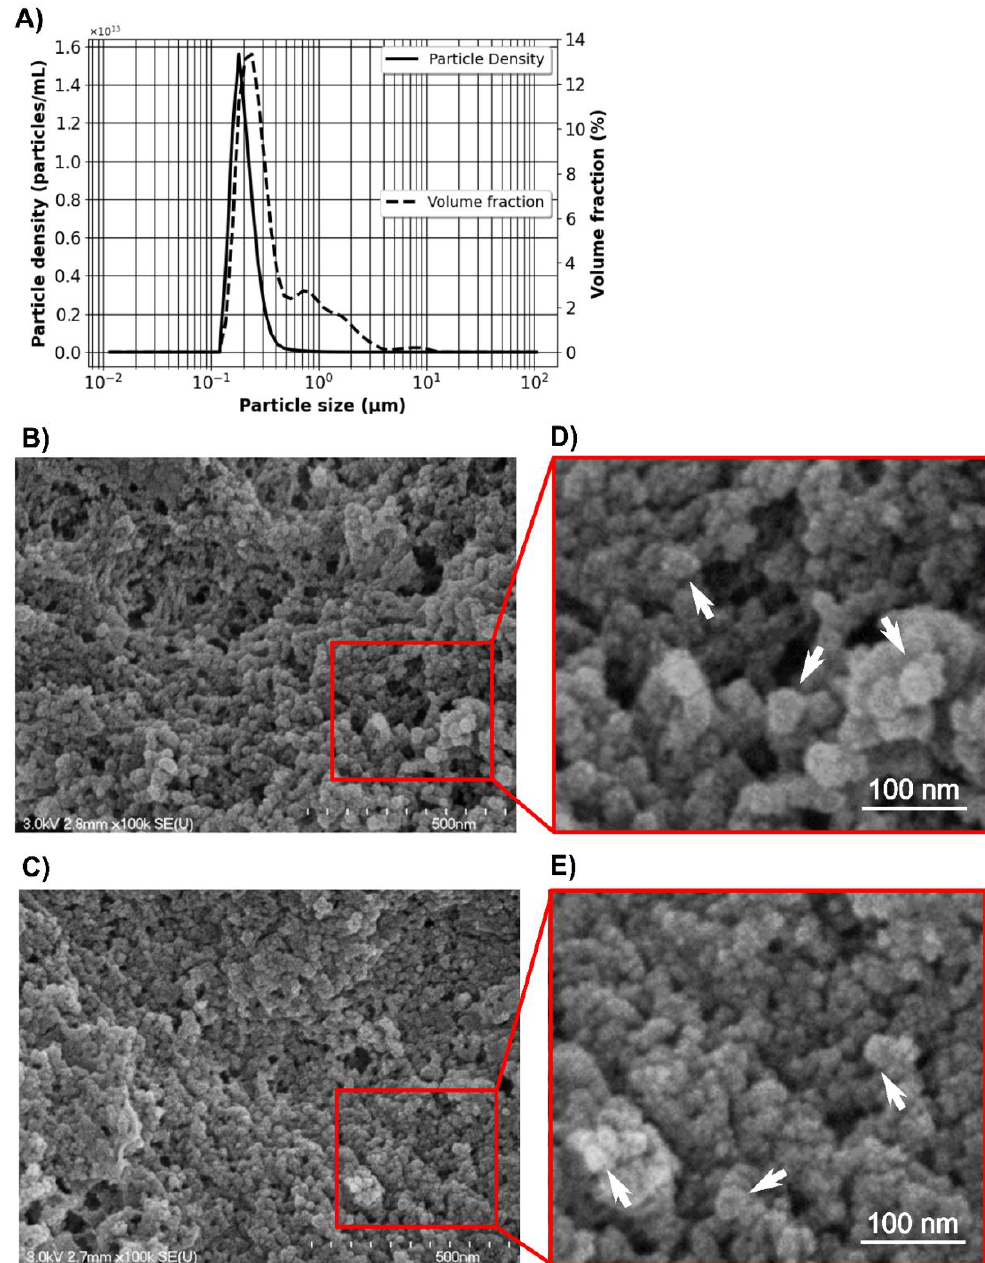
Figure 2. ( A ) Size distribution in volume % and particle density (number of particle / mL) of Alg / Chit NPs obtained from laser granulometry; 5–10 measurements were taken per experiment and the results are representative of three independent experiments. ( B ) Representative SEM images of empty NPs ( C ) and NPs containing CXCL12 (0.744 µ g / mg NPs). ( D ) and ( E ) are zoom regions highlighted by red squares for NPs and NPs-CXCL12, respectively. White arrows point to individual NPs.